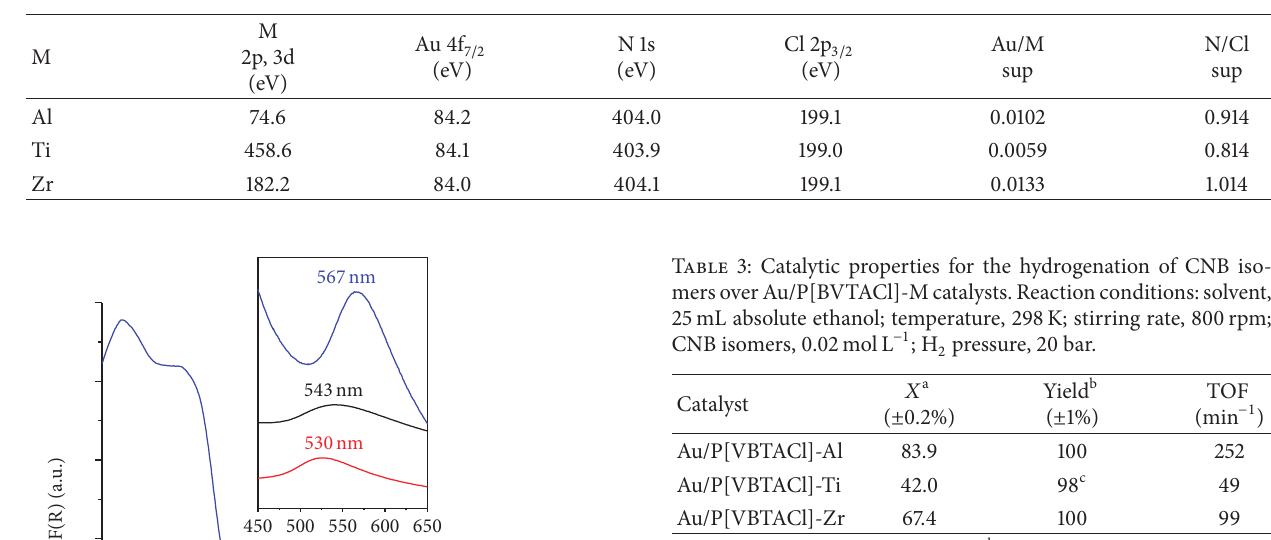
Table 2: Binding energies (eV) of internal electrons and atomic surface ratio of Au/P[VBTACl]-M catalysts.